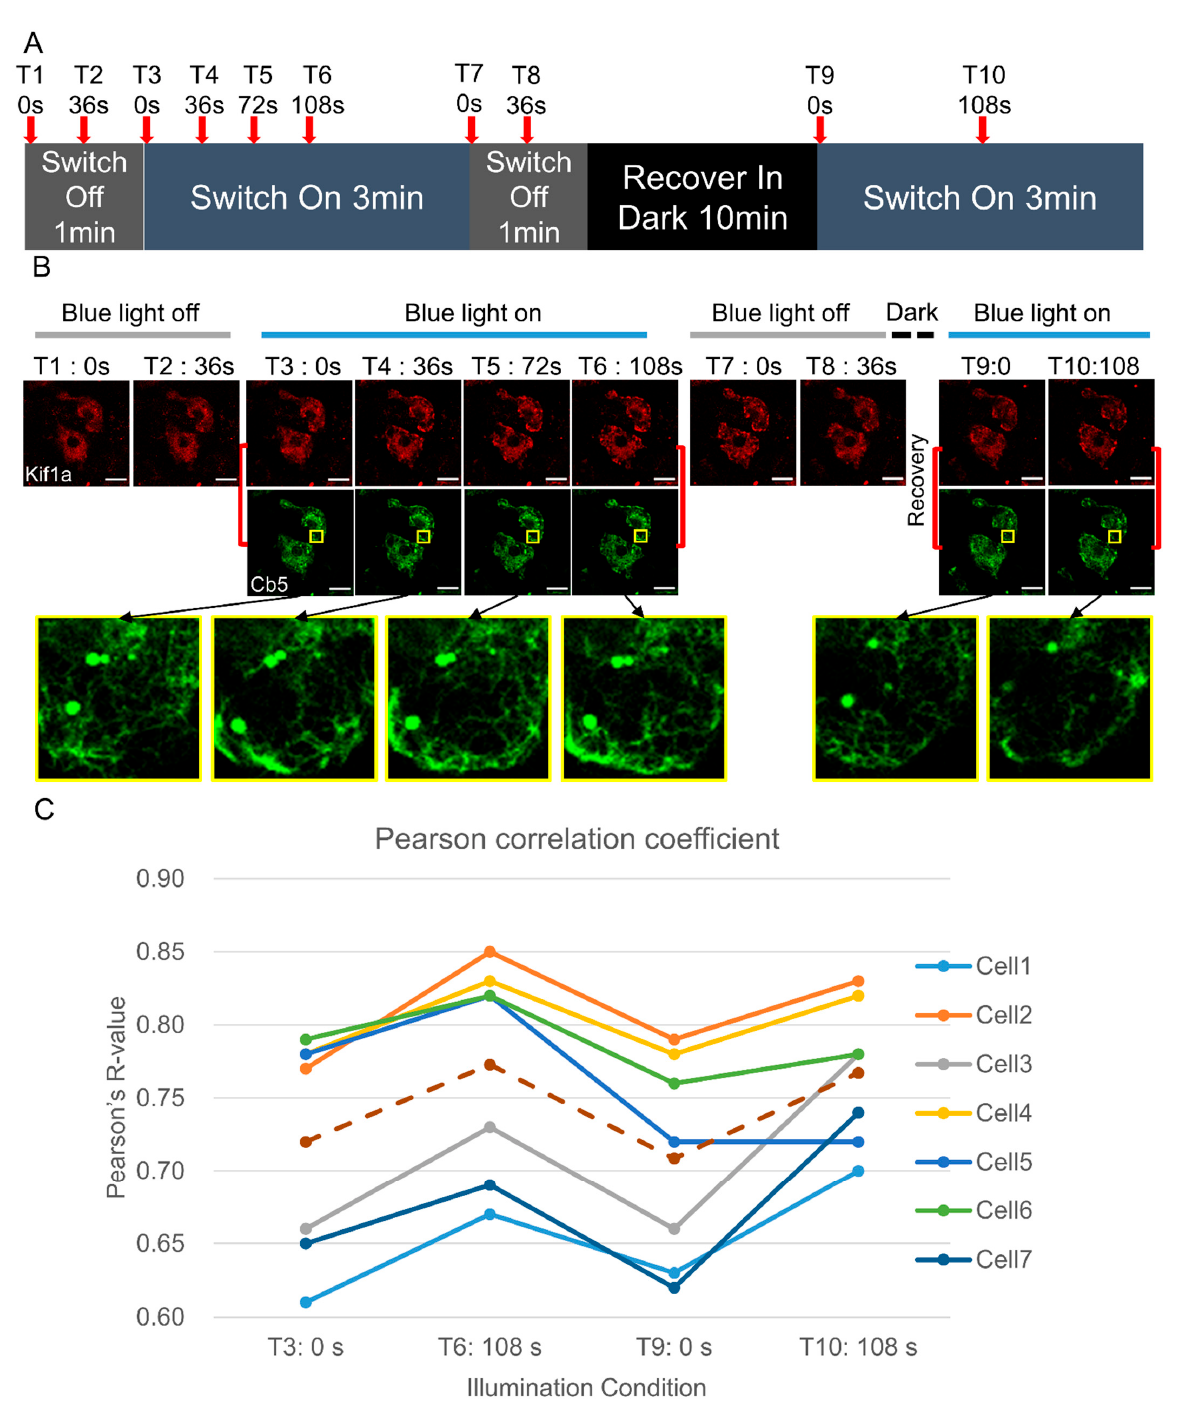
Figure 2. Live-imaging and quantitative analysis showing the reversibility and repeatability of the optoKiC. ( A ) The time window contained two rounds of activation with a 10 min dark interval. Red arrow: the time-point at which images were taken. ( B ) The series images of the live cells introduced with optoKiC were taken at 10 time-points, which showed the ER translocation during different light conditions. Yellow frame: zoomed images for a part of the cell from the center to the periphery. Black arrows: corresponding images and frames. Red lines: Paired images for Pearson’s R value calculation. ( C ) The co-localization analysis using the Image J Coloc2 plugin showed the reversibility and reusability of the ER translocation. The Pearson’s R value representing the interaction between iLID and SspB, using images of two channels as a group (Image connected by red lines in B ) Scale bars: 25 µ